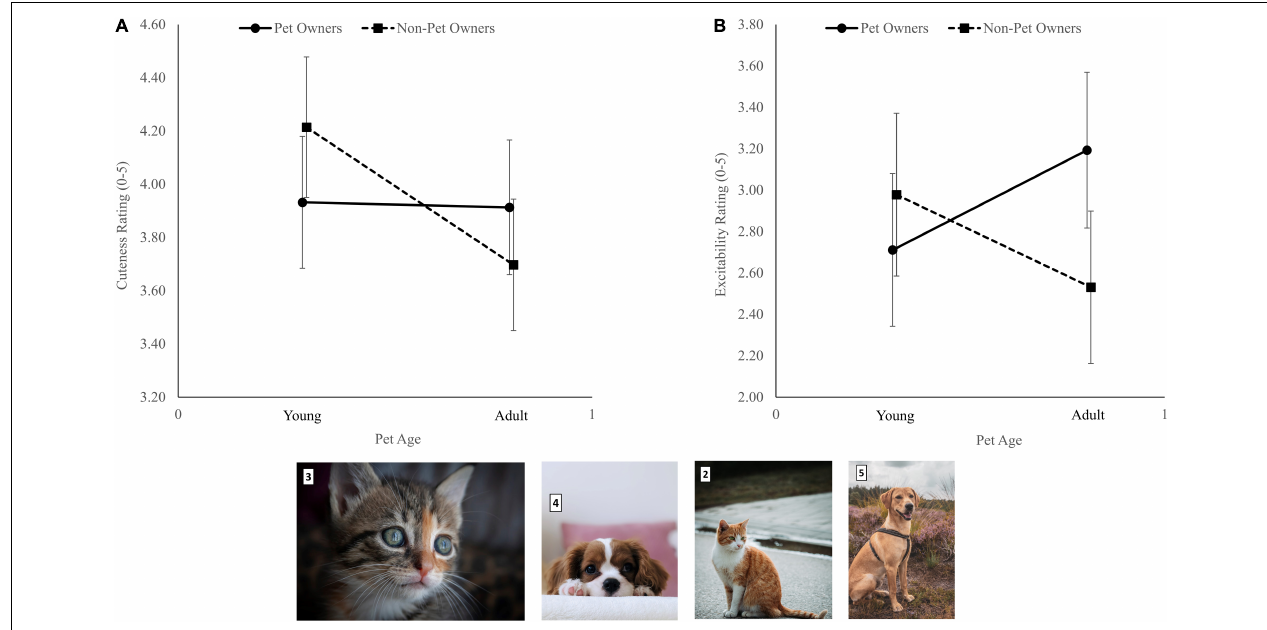
FIGURE 1 | The interaction between pet ownership and ratings of young and old pets’ images for cuteness (A) and excitability (B) . Error bars represent 95% confidence intervals. Photos are samples of the baby (3 and 4) and adult (2 and 5) pets’ photos used in this study (Photo # 2 by Daniel Maˇcura on Unsplash; photo # 3 by Adél Gröber on Unsplash; photo # 4 by T.R Photography on Unsplash; Photo # 5 by Sam te Kiefte on Unsplash).